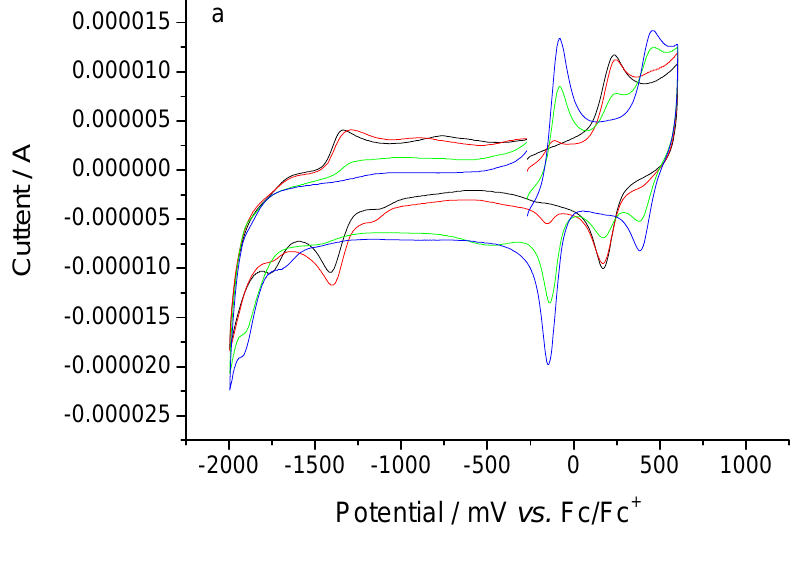
Figure 2. Cyclic voltammograms of 7.06 × 10 -5 M AqFcSAc (0 (black), 0.5 (red), 1.0 (green), 2.0 (blue) equiv of TfOH) (a) and 7.51 × 10 -5 M FcAqFcSAc (0 (black), 0.5 (red), 1.0 (green), 2.0 (blue) equiv of TfOH) (b) on addition of TfOH at GC electrode in 0.1 M n- NClO -dichloromethane at a scan rate of 100 Bu 4 4